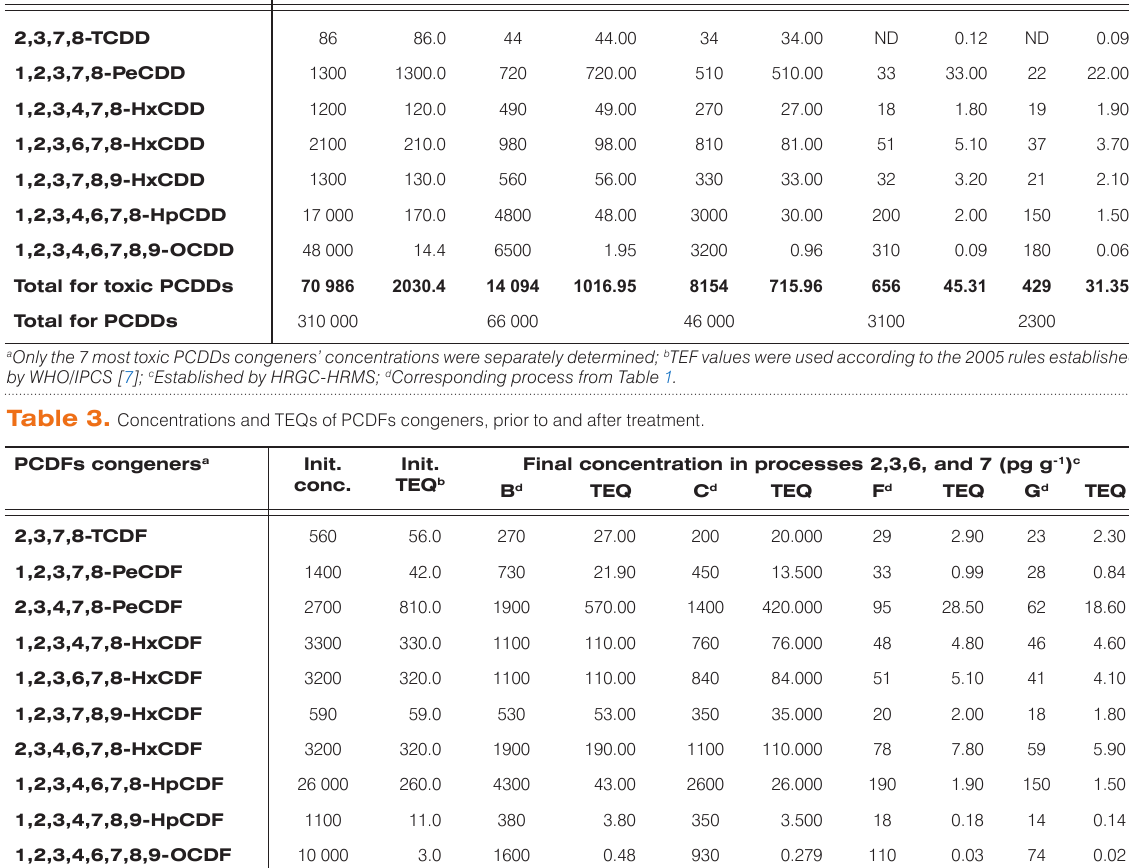
Table 2. Concentrations and TEQs of PCDDs congeners, prior to and after treatment. PCDDs congeners a Init. conc.